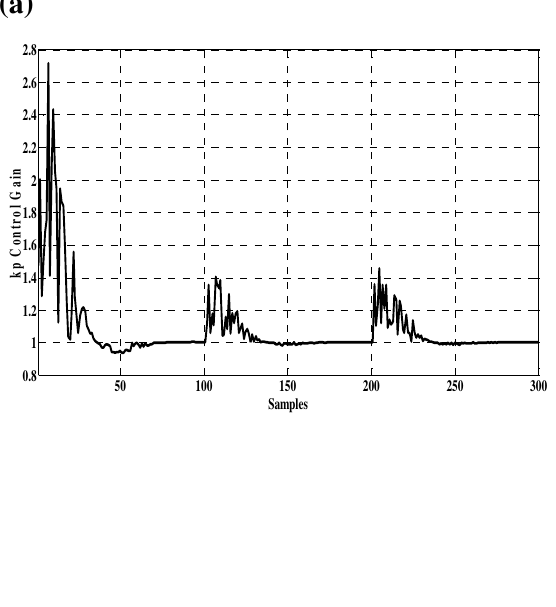
Fig. 8. Simulation results of the control parameters: (a) kp; (b) ki; (c) kd and (d) Vc.